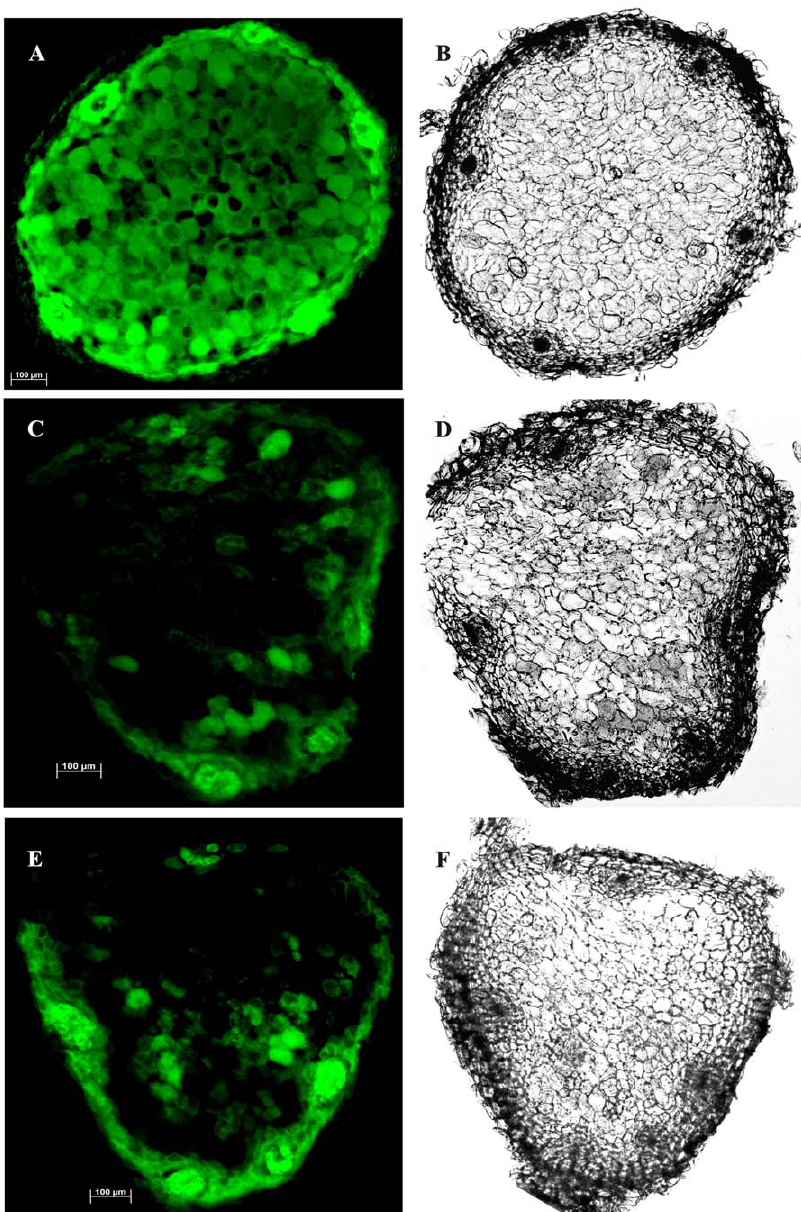
Figure 3. Detection of RSNO in M.sativa nodules. Control set cross sections of 143 day old M. sativa nodules (A) were treated with buffer only; sections (C) were treated with 50 mM L-NEM and were incubated at 25 u C for 2 h in darkness; sections (E) were incubated with 20 mM ascorbate for 1 hour at room temperature followed by similar NEM treatment. All the sections were stained with 10 m M alexafluor 488 at 25 u C for 2 h in darkness. Photographs are representative of results obtained from the analysis of nodules in five independent experiments. Green fluorescence of (A) depicts the presence of RSH, RSNO, disulphide linkage and background fluorescence, the fluorescence of (C) is due to RSNO, disulphide linkage and background fluorescence whereas (E) represents the fluorescence for disulphide linkage and back ground. The fluorescence intensity is not downward for E from C. This confirms the absence of RSNO (for calculations see further Figure 4) in the M. sativa nodule sections. (B), (D), and (F) represents the corresponding bright field images. Scale bar=100 m m. In eukaryotes and prokaryotes, the tripeptide glutathione (GSH) glutathione (GSH) as markers of cellular glutathione status in its reduced state acts as an important constituent of cellular first following 1 mM and 3 mM SNP stress for 30 min. There was a , 3.3 fold increase in total thiol in S. meliloti 1021 following line of defense against oxidative stress and helps to maintain intracellular redox balance. So we investigated the effect of nitrosative stress on cellular glutathione level both in Bradyrhizobium sp and S. meliloti (Table 2). We measured total glutathione (GSH + GSSG), oxidized glutathione (GSSG) and calculated reduced